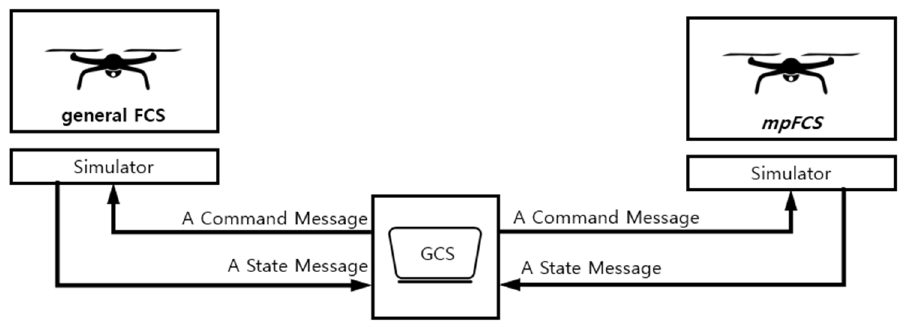
Figure 9. The process of the compared running of original FCS and mpFCS.